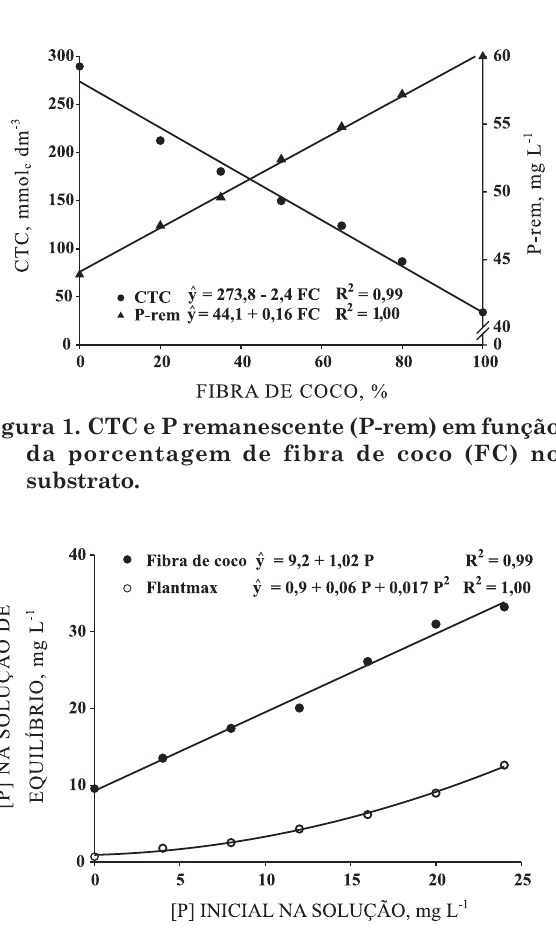
Figura 2. Recuperação de P, após 24 h de contato de 2,00 g dos substratos fibra de coco e Plantmax com 50 mL de solução com P.